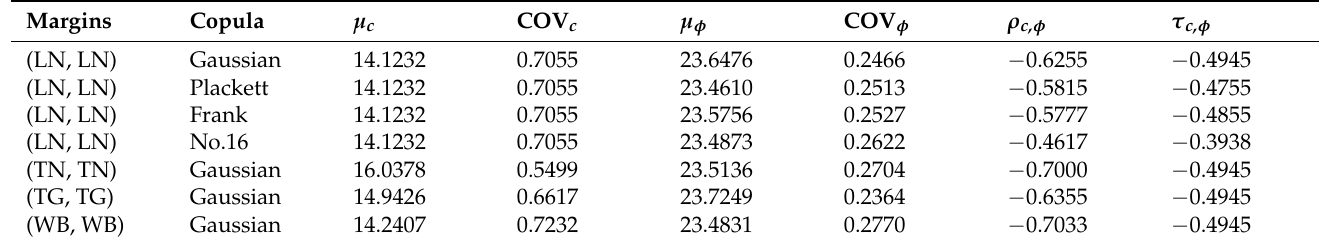
Table 12. Statistics of CCRF variables associated with candidate margins and copulas.